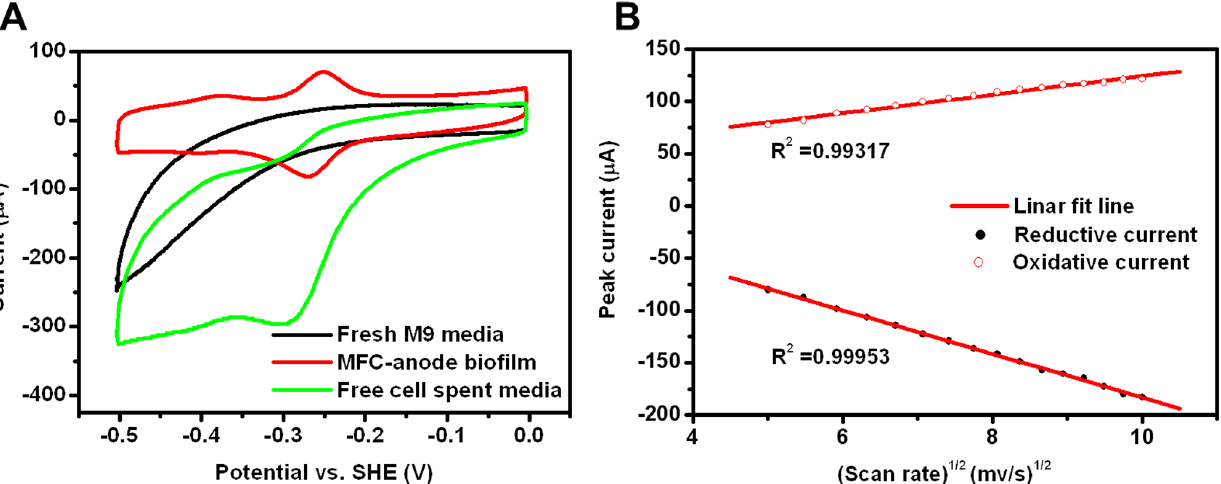
Fig 5. CV analysis of A . andensis ANESC-S T in MFCs. (A) CV traces of MFCs inoculated with fresh M9 media, A . andensis ANESC-S T and free cell spent media of A . andensis ANESC-S T . The working electrode is carbon felt, counter electrode is Pt wire and the reference electrode is Ag/AgCl. Scan rate is 5 mV/s. Voltammograms were acquired in the presence of 10 mM L-Arabinose. (B) Plot of peak current vs. scan rate of the CV traces. All experiments were performed in triplicates.